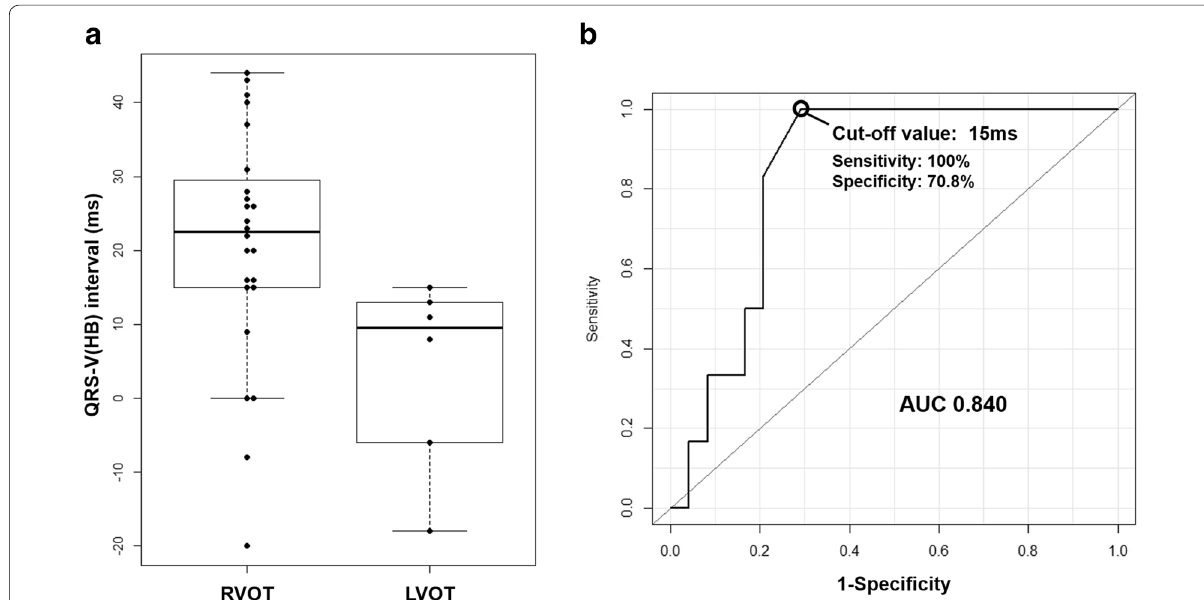
Fig. 4 a Boxplots of the QRS‑V(HB) intervals (interval from the onset of the earliest QRS complex in 12‑lead surface electrocardiogram to the V signal in the His bundle electrogram) for idiopathic ventricular arrhythmia originating from the RVOT and LVOT. b ROC curve of the QRS‑V(HB) interval. A QRS‑V(HB) interval cutoff of 15 ms predicted an origin from the LVOT with 100% sensitivity and 70.8% ≤